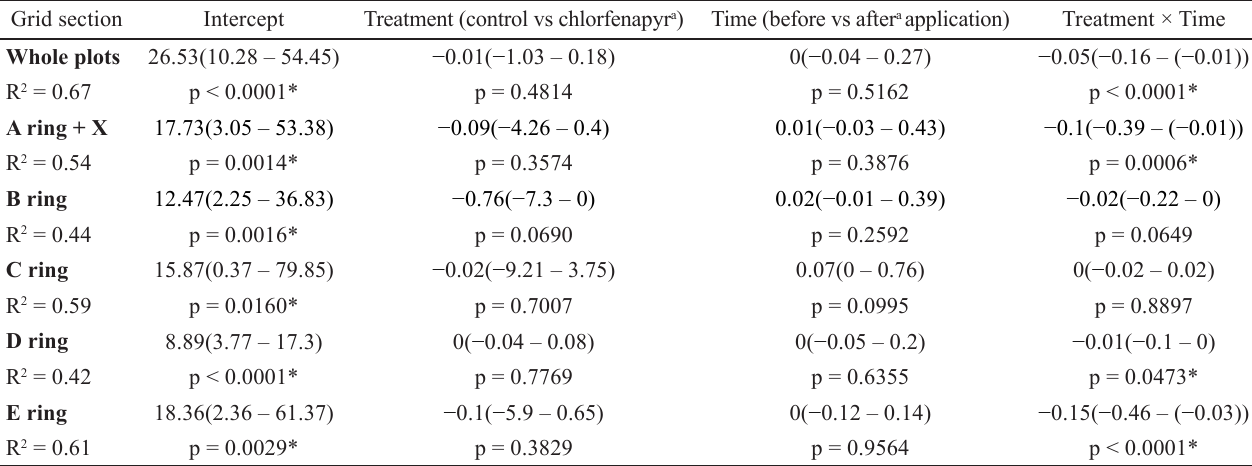
Table 3 . Results of mixed-effects multiple linear regression models for differences between control and chlorfenapyr-treated experimental grids based on the mean number of termites collected per station. Parameter estimates are displayed with their 95% confidence intervals. Parameter estimates and confidence intervals were back-transformed before including them in this table. For the interaction term, positive parameter estimates imply higher percentages of stations occupied by H. aureus relative to controls after treatment, while negative values imply a decrease. Only fixed effects are